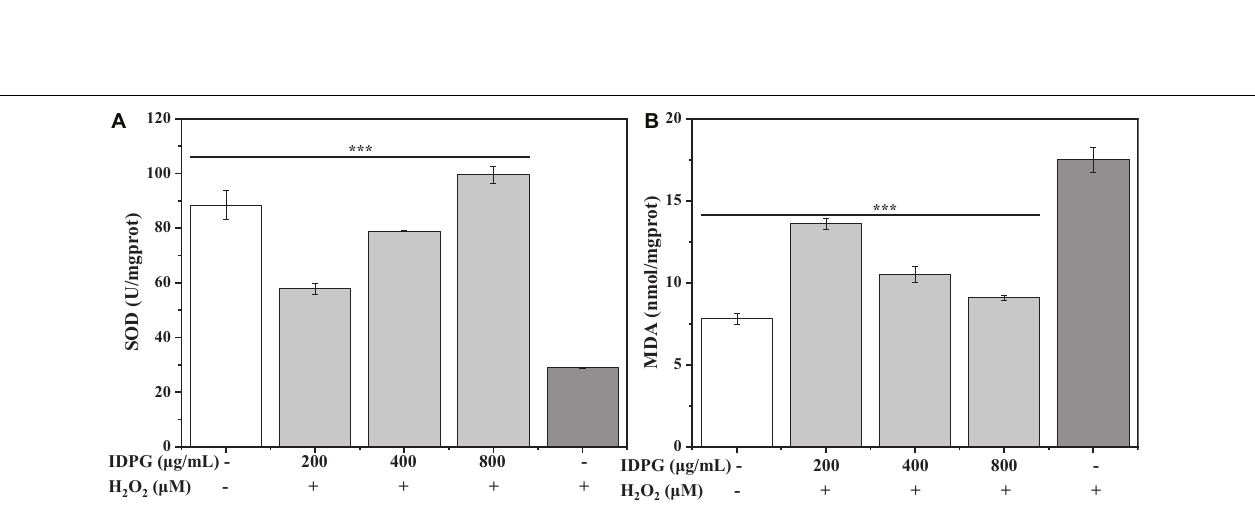
FIGURE 2 | Effects of incomplete degradation products of galactomannan (IDPG) on the production of superoxide dismutase (SOD) (A) and malondialdehyde (MDA) (B) in